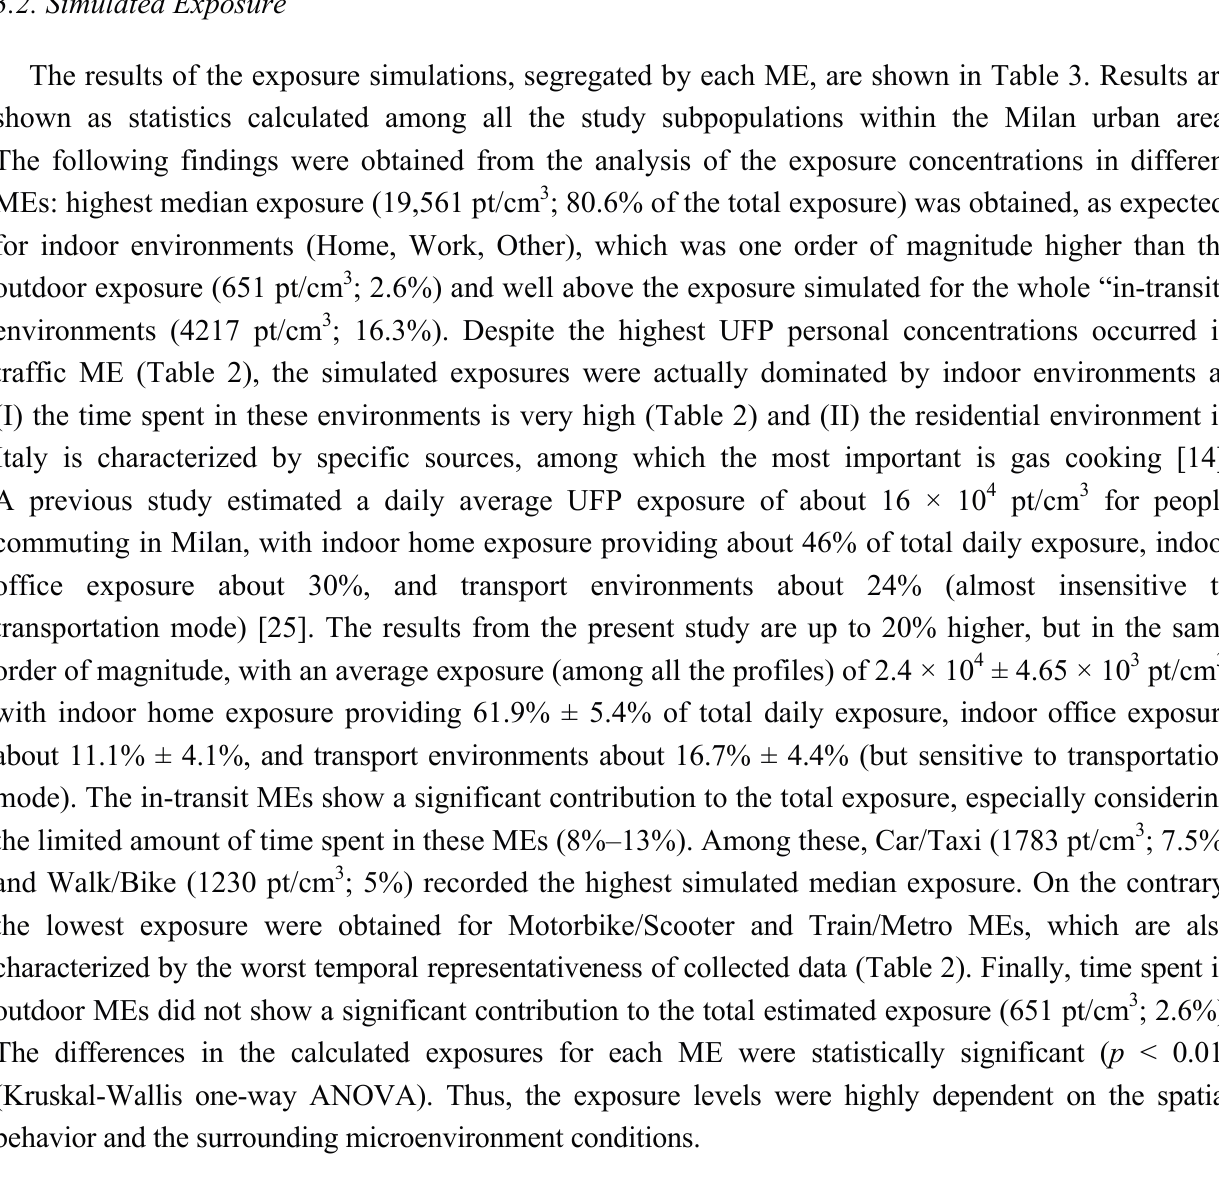
Table 3. Summary of the mean simulated exposures segregated for each ME. Results are calculated among all subpopulations within the Milan city area (SD = standard deviation, Min = minimum, Max = maximum, p5 = 5th percentile, p95 = 95th percentile). All results are expressed in particle/cm 3 (pt/cc). Mean value are expressed also as percentual contribution to total daily exposure